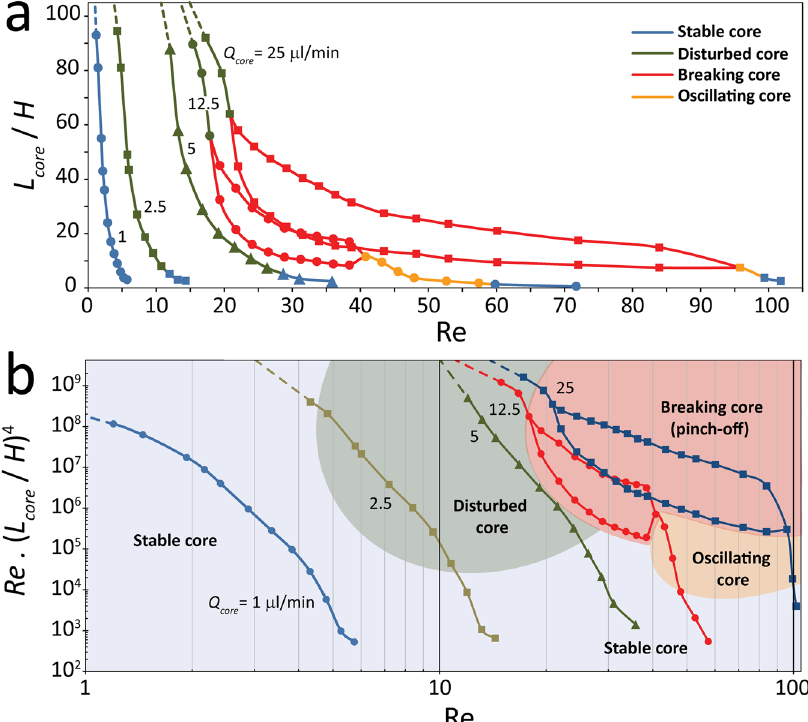
Figure 7. ( a ) Variation of dimensionless core length against Reynolds number under various combinations of core and sheath flow rates, as presented in Figs 3 to 6, and ( b ) Variation of Re. ( L core / H ) 4 (representing the deflection of glycerol core flow under dynamic loads) against Reynolds